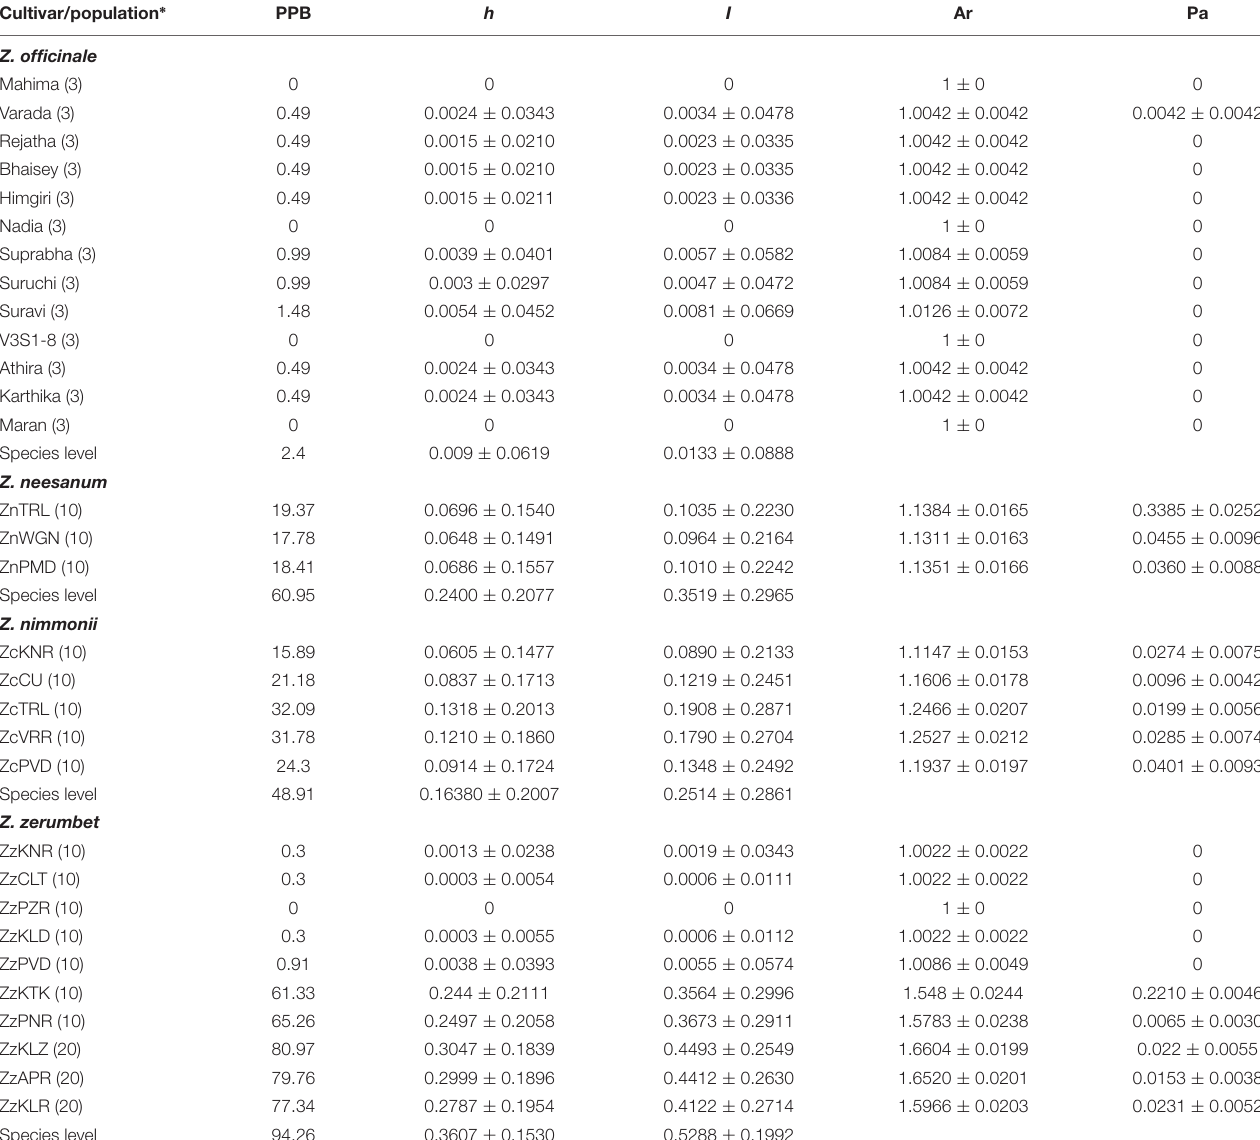
TABLE 2 | Genetic diversity characteristics of Zingiber spp. based on amplified fragment length polymorphism